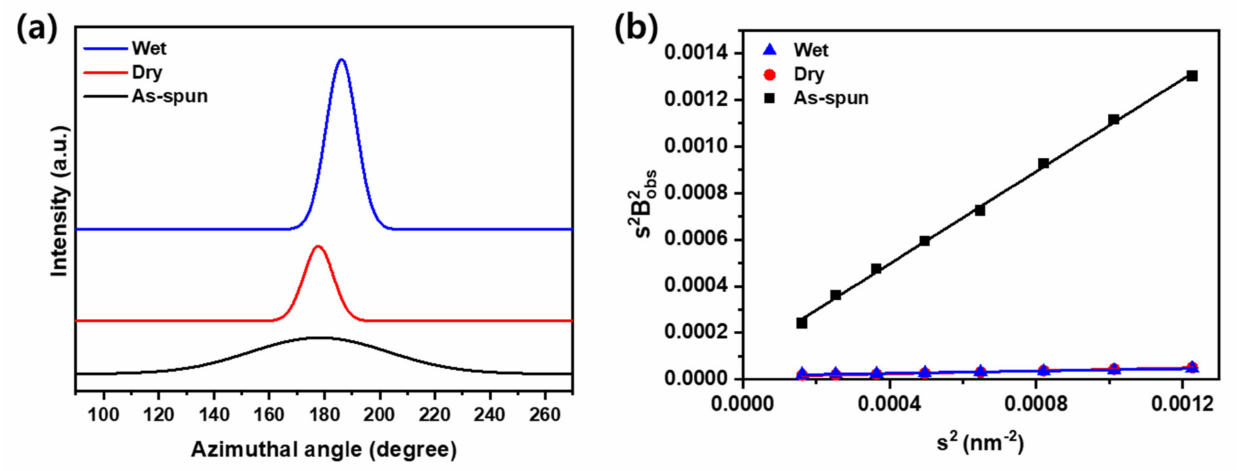
Figure 6. Two-dimensional small-angle X-ray scattering (SAXS) results of PAN fibers. ( a ) Azimuthal scan of the fibers and ( b ) Ruland streak linear